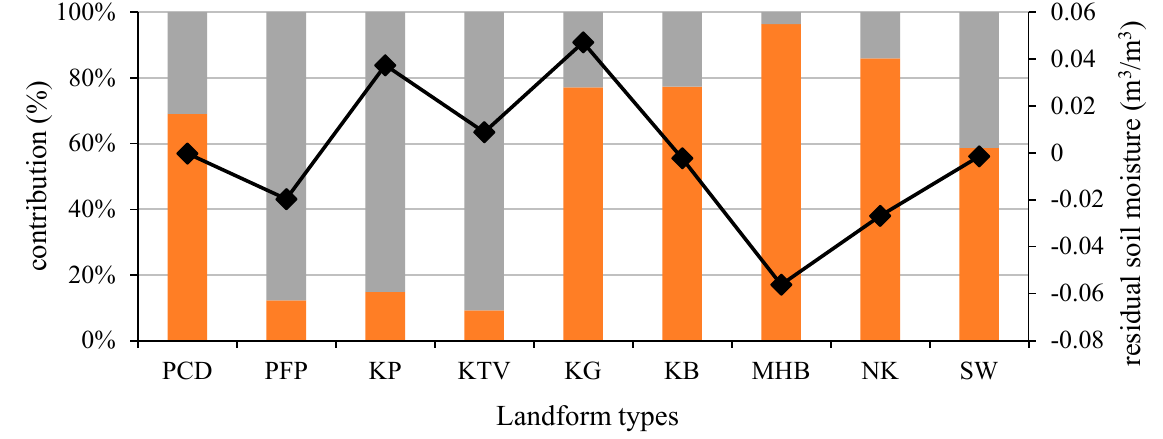
Figure 9. Residual soil moisture and the contributions of human activities and climate change to soil moisture trends in the karst areas of Southwest China from 2000 to 2015 (PFP: peak forest plain; KG: karst gorge; NK: non-karst region; KB: karst basin; MHB: middle-high hill; PCD: peak cluster depression; KTV: karst trough valley; KP: karst plateau).